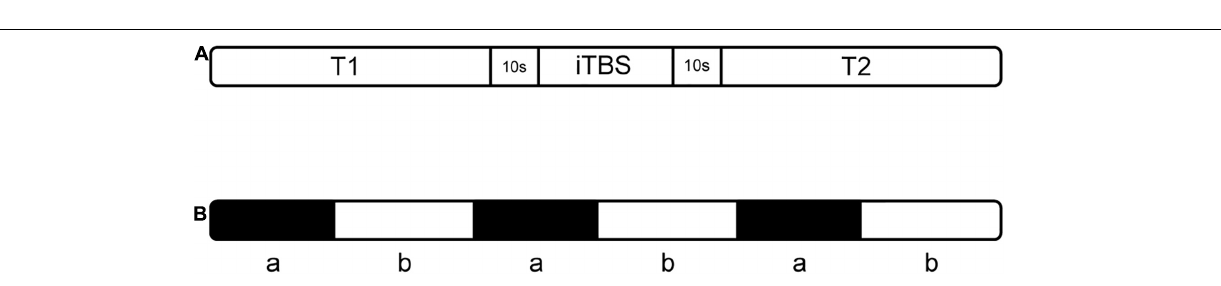
FIGURE 3 | The experimental procedure (A) includes three phases; “T1” and “T2” indicate balance tasks, (B) balance task in T1 and T2: “a” means standing on the right leg for 15 s, “b” means resting for 20 s while standing.